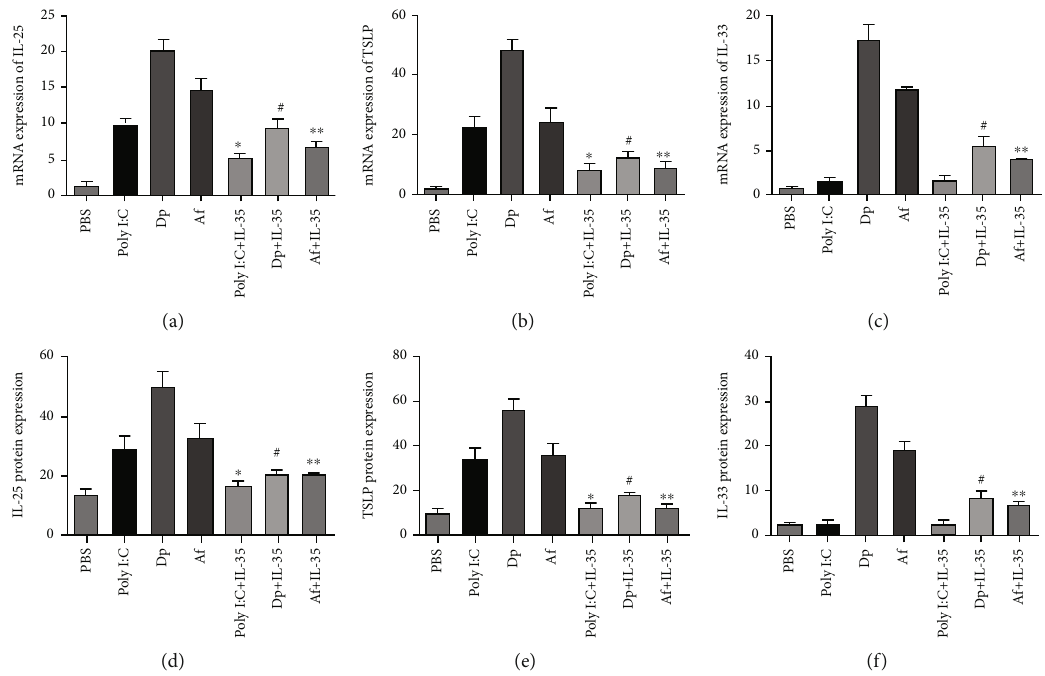
Figure 1: The expression of IL-25, IL-33, and TSLP by human nasal epithelial cells after various stimulators. (a – c) The mRNA expression of IL-25, IL-33, and TSLP by human nasal epithelial cells. (d – f) The protein expression of IL-25, IL-33, and TSLP by human nasal epithelial cells. Poly I:C: 25 μ g/mL polyinosinic-polycytidylic acid; Dp: 1.6 μ g/mL of Dermatophagoides pteronyssinus; Af: 2.6 μ g/mL of Aspergillus fumigatus; IL-35: 100 ng/mL interleukin-35. ∗ Compared with Poly I:C, P < 0 : 05 ; # compared with Dp, P < 0 : 05 ; ∗∗ compared with Af, P < 0 : 05 . Three independent tests were performed for every